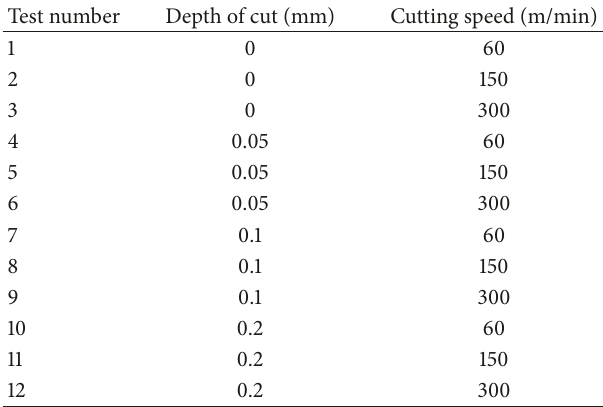
Table 1: Test plan of the experimental design, to obtain acceleration (g) and force